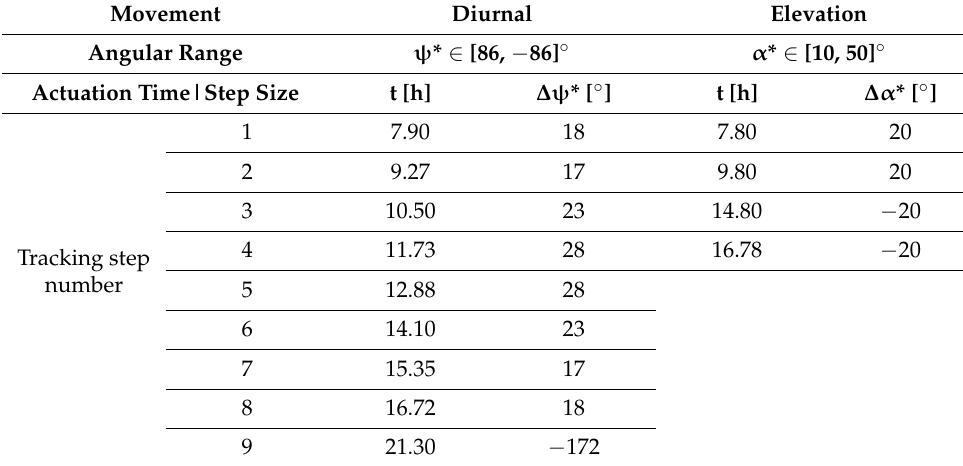
Table 5. Tracking program “4”/“10”.